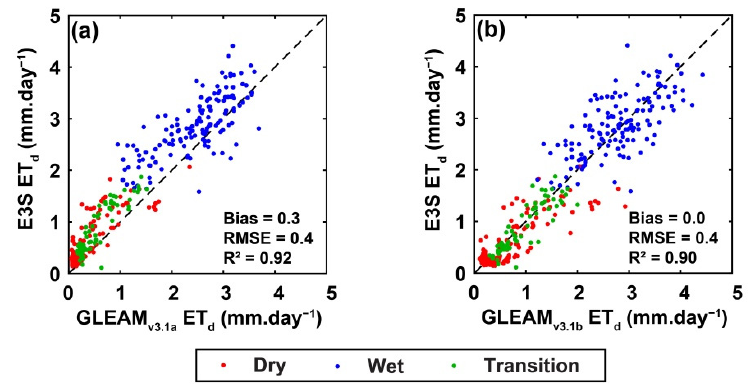
Figure 14. Comparing mesoscale-averaged daily ET d from blended E3S and GLEAM versions ( a ) 3.1a and ( b ) 3.1b.